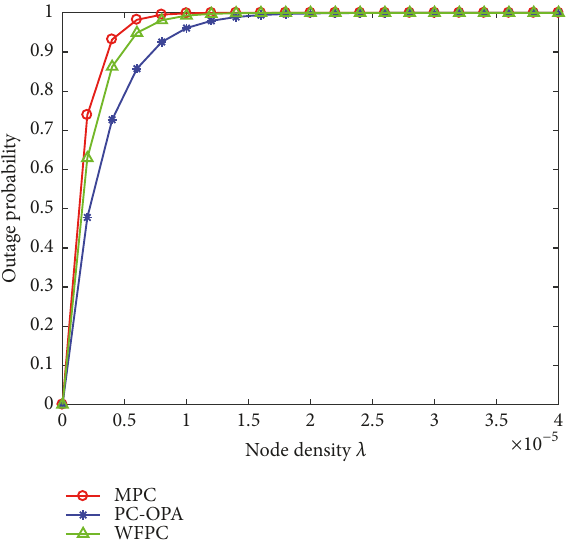
Figure 8: The outage probability for different algorithm versus 𝜆 density of nodes (Doppler frequency shift).